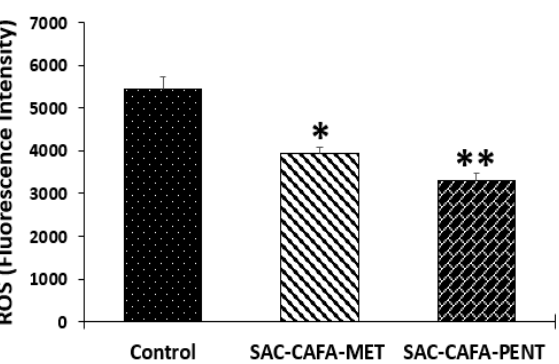
Figure 1. Intracellular ROS induced by the hybrids SAC-CAFA-MET (124.2 µ M) and SAC-CAFA- PENT (118 µ M) or 1% DMSO (control) in SW480 cells. The fluorescent dye CM-H2DCFDA was used. Data are presented as the mean ± SE of three independent experiments; p -values lower than 0.05 were considered statistically significant (* p < 0.05; ** p < 0.01).